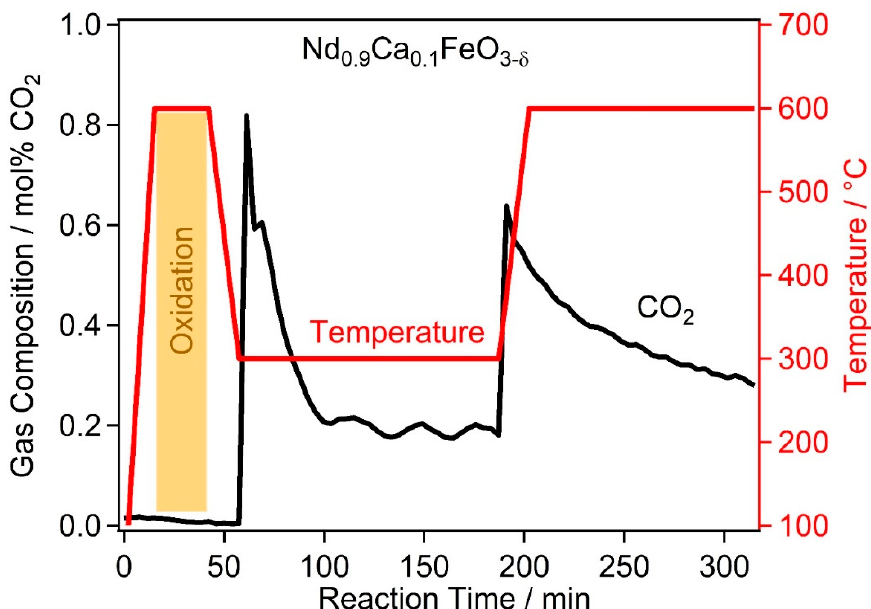
Figure 3. Reaction of pure CO with the Nd 0.9 Ca 0.1 FeO 3- δ perovskite. After oxidation at 600 ◦ C and cooling to 300 ◦ C, the gas flow was switched to CO / Ar (0.70 and 11.3 mL min − 1 , respectively). The conditions were held for 2 h and then the temperature was raised from 300 to 600 ◦ C. Increased formation of CO 2 could be observed at the beginning of each phase (both after switching the atmosphere and after increasing the temperature), which was then dropping rapidly.